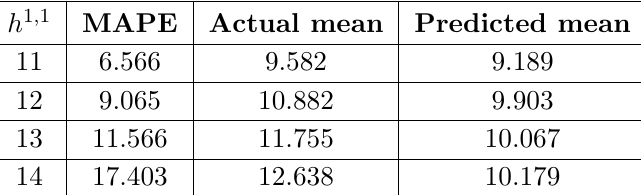
Table 2 . Prediction results for ln( N FRT ), using the ExtraTreesRegressor model, for h 1 ; 1 values outside of its training